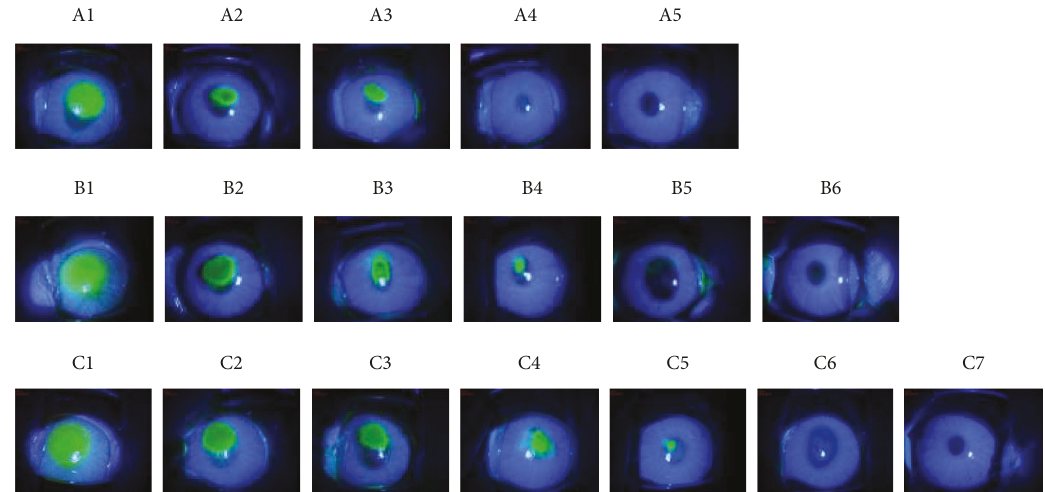
Figure 1: Corneal staining analysis in each group at 0h, 12h, 36h, 48h, 60h, and 72h after operation. Group A: 0h (A1), 12h (A2), 24h (A3), 36h (A4), 48h (A5); Group B: 0h (B1), 12h (B2), 24h (B3), 36 h (B4), 48h (B5), 60h (B6); Group C: 0h (C1), 12h (C2), 24h (C3), 36h (C4), 48h (C5), 60 h (C6), 72h (C7). The corneal fluorescence staining at 12h, 24h, 36h, 48h, and 72h after operation: the staining area of